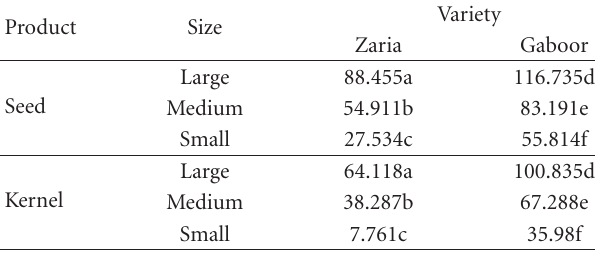
Table 1: Mean comparison of elastic modulus (Mpa) of pumpkin seed and kernel considering the interaction e ff ect of variety and